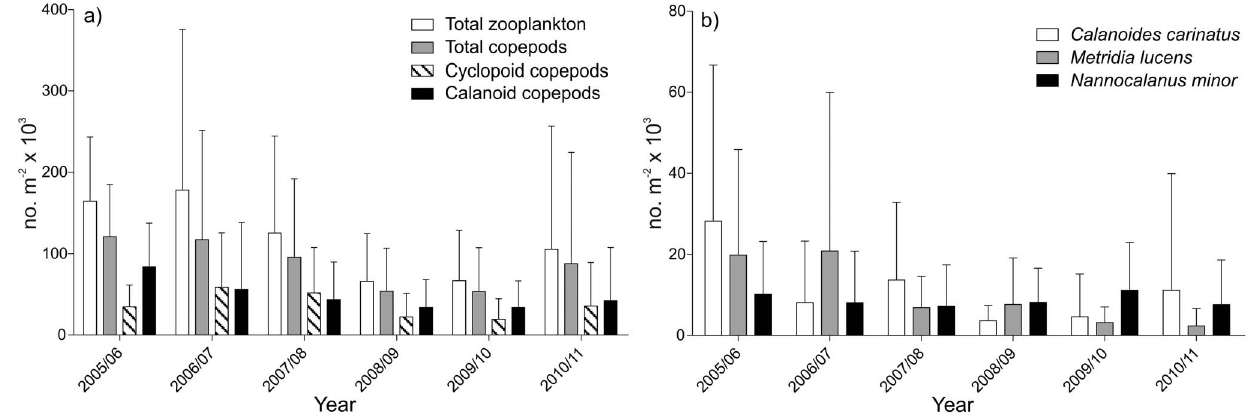
Figure 7. Mean annual abundance (no. m 2 2 6 10 3 ± SD) of a) total zooplankton, total copepods, cyclopoid and calanoid copepods and the dominant species b) Calanoidescarinatus , Metridialucens and Nannocalanusminor for each year recorded.